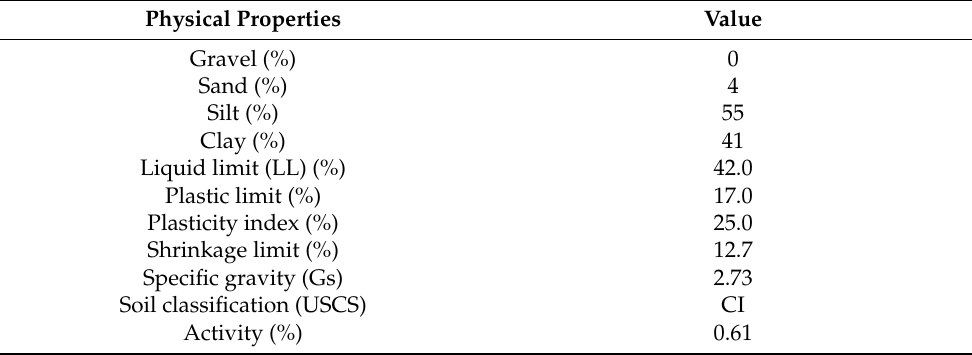
Table 1. Properties of the marl soil.